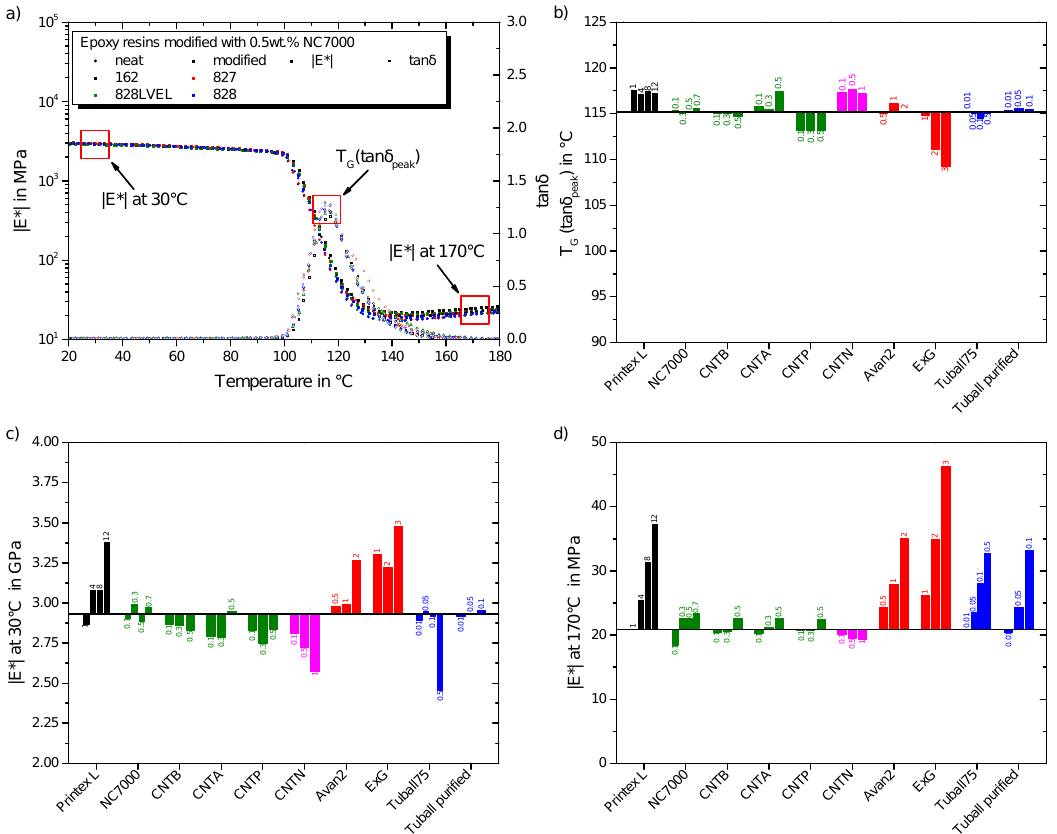
Figure 11. Resulting DMTA properties: ( a ) impact of 0.5wt.% NC7000 in epoxy resins Epikote 162, 827, 828LVEL, and 828 ( b ) effect of evaluated particles on the glass transition temperature ( c ) effect of evaluated particles on the complex modulus at 30°C ( d ) effect of evaluated particles on the complex modulus at